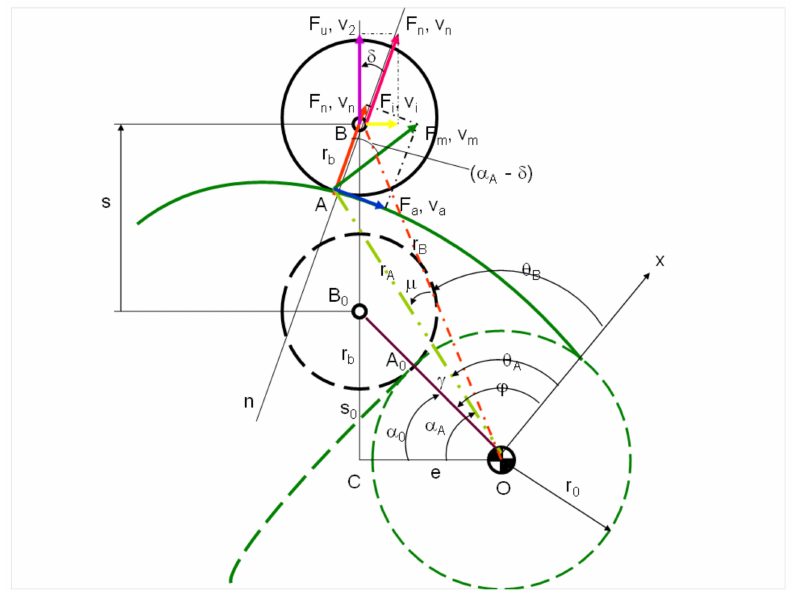
Figure 5. A mechanism with rotating cam and adept with roller in translational